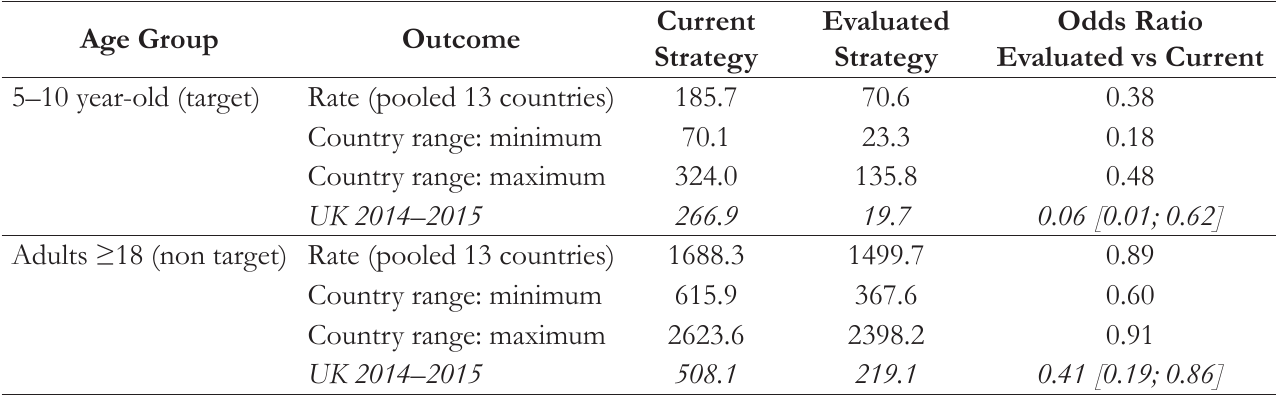
Table 3. PCC per 100,000 Population-years and OR with Evaluated versus Current Strategy, Model versus UK